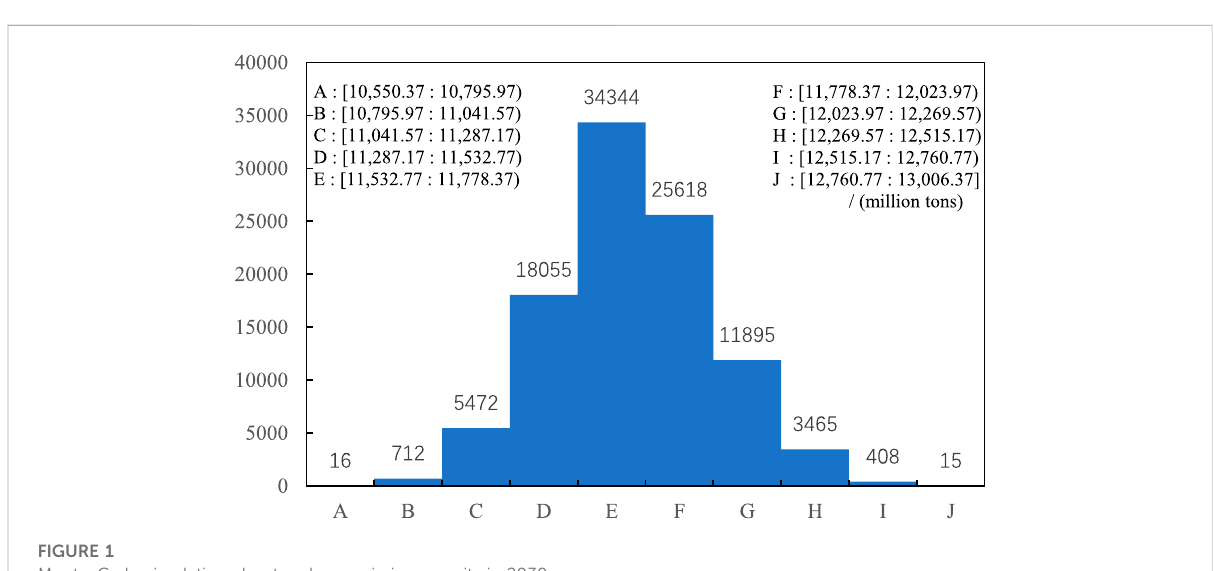
Monte-Carlo simulation about carbon emission permits in